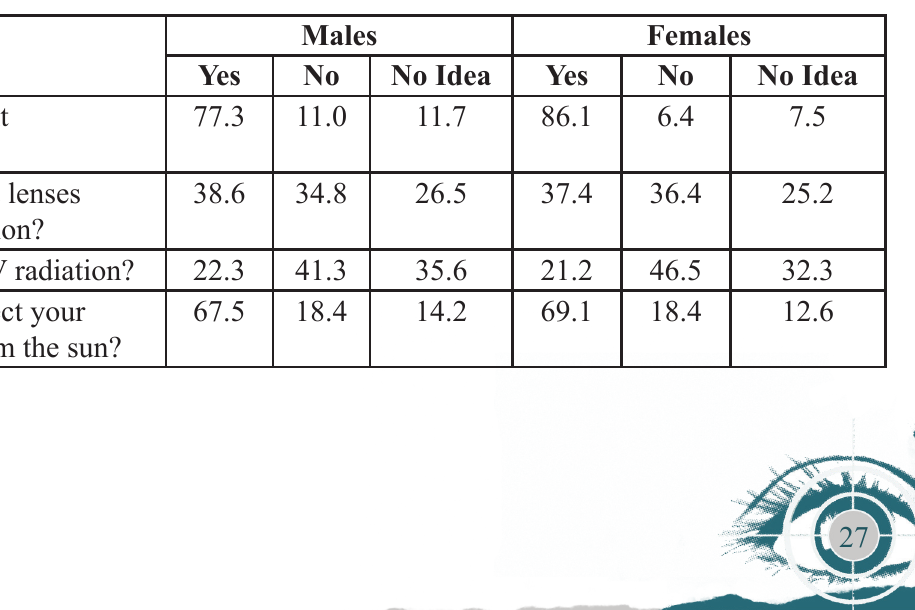
Table 2: Intra-gender (within gender) responses who responded to the questions as stated. A greater percentage of females (86.1%) than males (77.3%) knew that excessive sunlight can adversely affect the eyes. Higher percentages of the females knew the correct answer to all the questions included in the